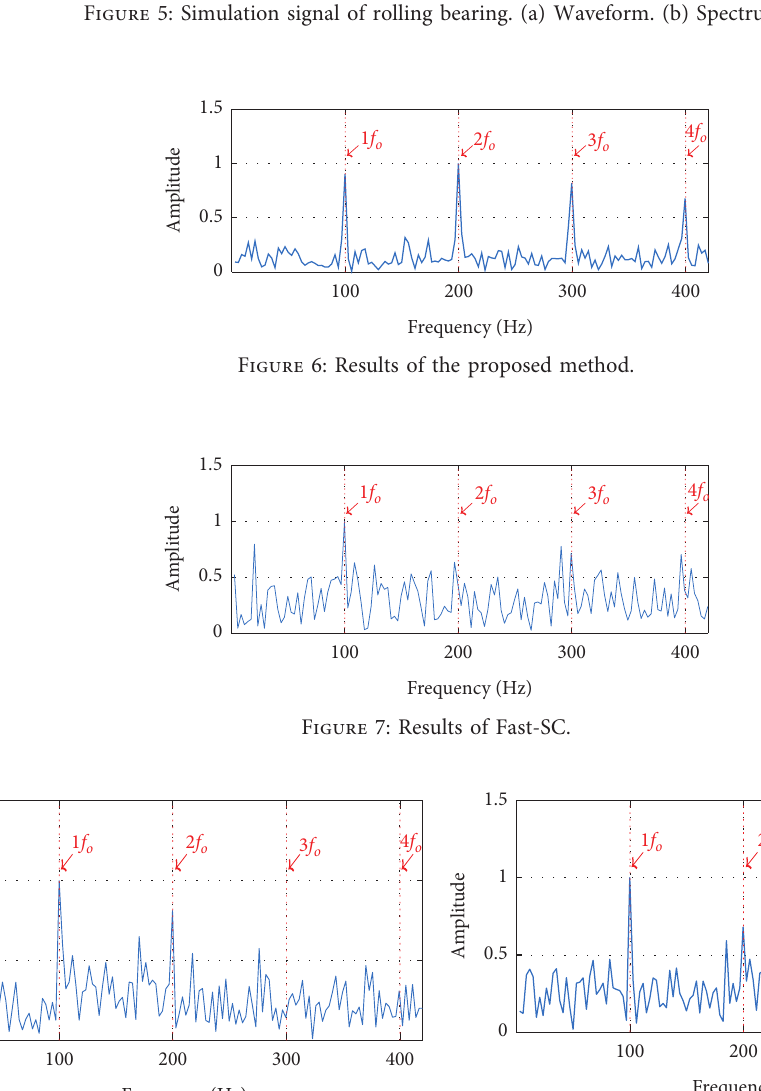
Figure 5: Simulation signal of rolling bearing. (a) Waveform. (b) Spectrum.